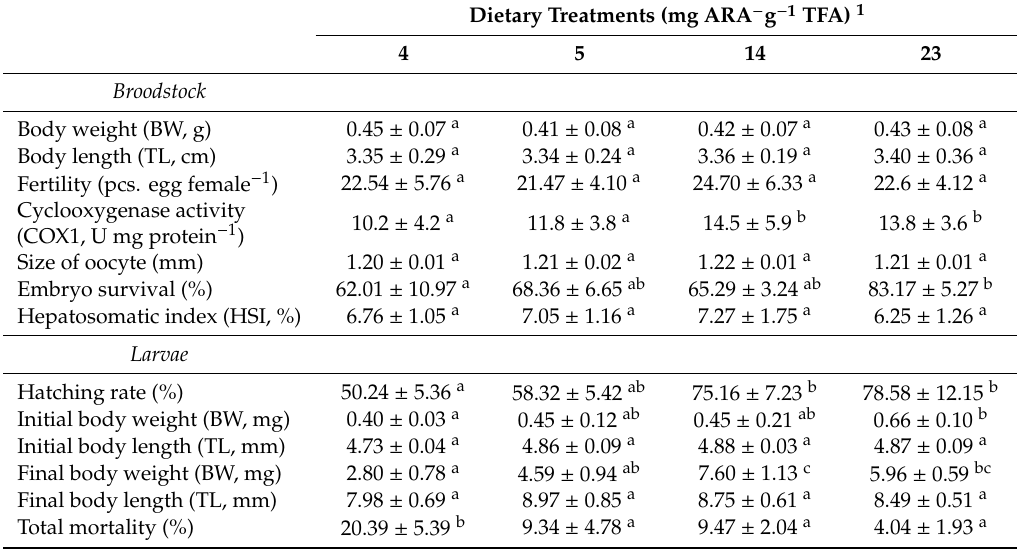
Figure 1. Effect of dietary ARA level (4, 5, 14, 23 mg ARA g − 1 TFA) in broodstock diet on the fertility of medaka females during three weeks of experimental diet feeding. Values are means ± standard deviation (SD); each dietary treatment was carried out in triplicate ( n = 3). Table 2. Reproduction parameters of medaka obtained from broodstock fed experimental diets after three weeks of